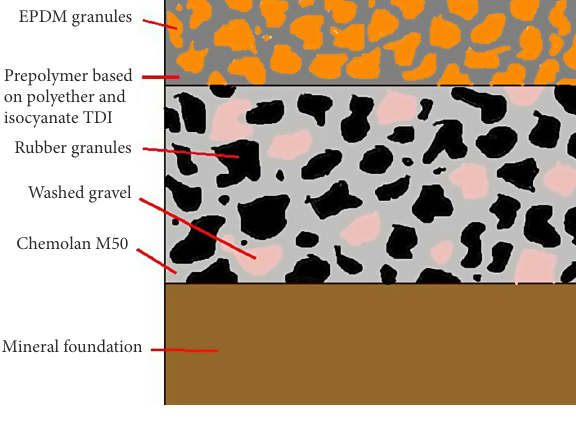
.Figure 6. Diagram of the cross-section of the Eltan P Table 5. Examples of the calculation of the fuzzy distance between the fuzzy sets A and B Formula name